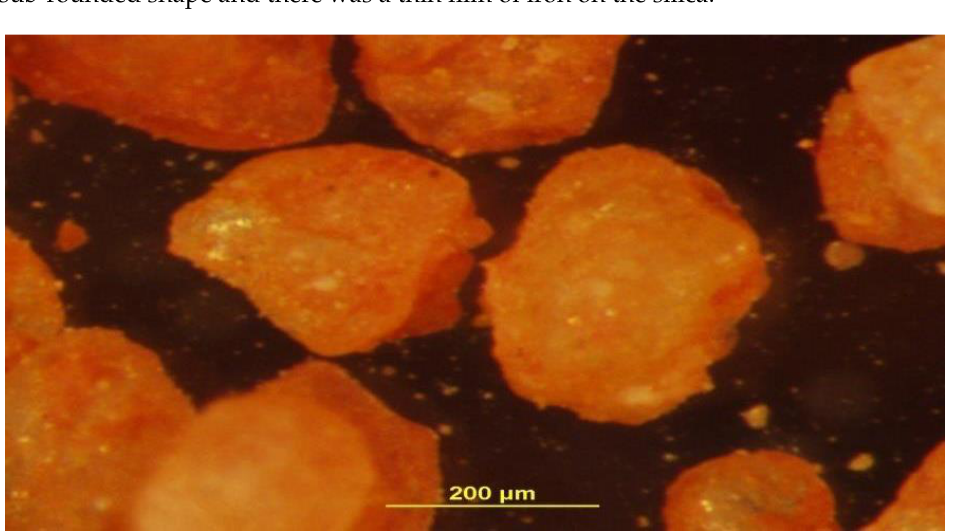
Figure 4. Optical microscopic view of the untreated Skye sand.